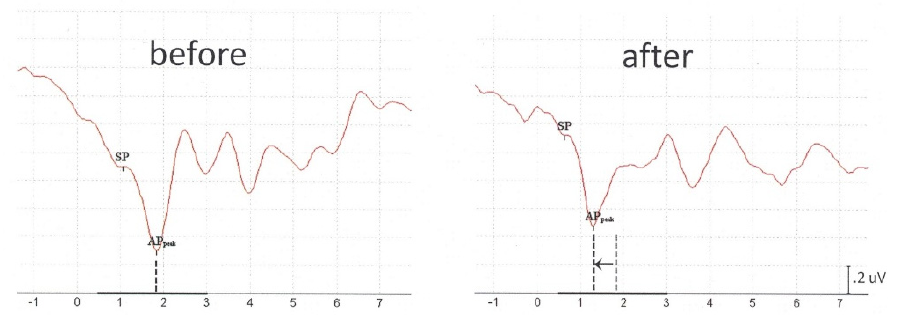
Figure A1. Typical SP/AP example of acute TM-ECochG within-subject recording before absorp- tion of xylocaine showing a prolonged AP latency (left graph) and after absorption (right graph). Responses obtained by 90 dBnHL click stimulus in alternating polarity, stimulation rate 11.3/s and band pass filtered 100–3000 Hz.